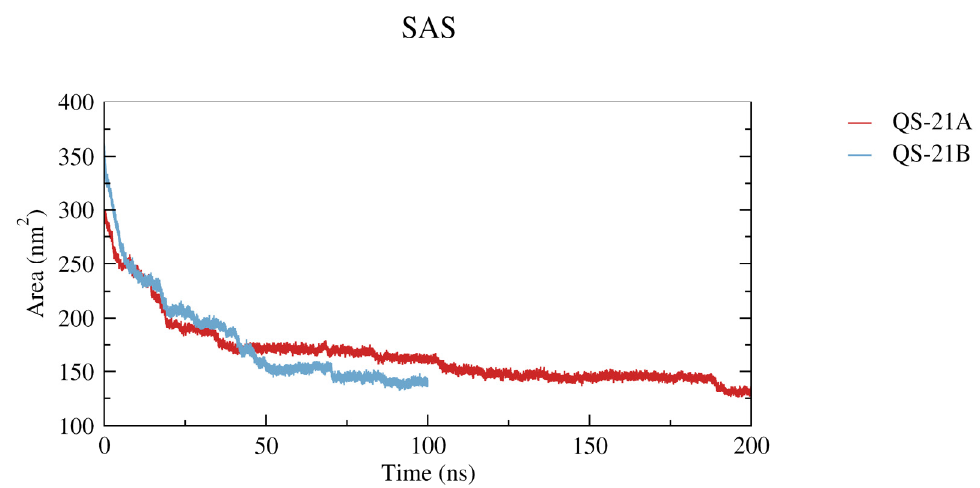
Figure 7. Solvent accessible surfaces for (QS-21A) equilibrated, (QS-21A) presents an average of 139.9 ± 2.0 nm 2